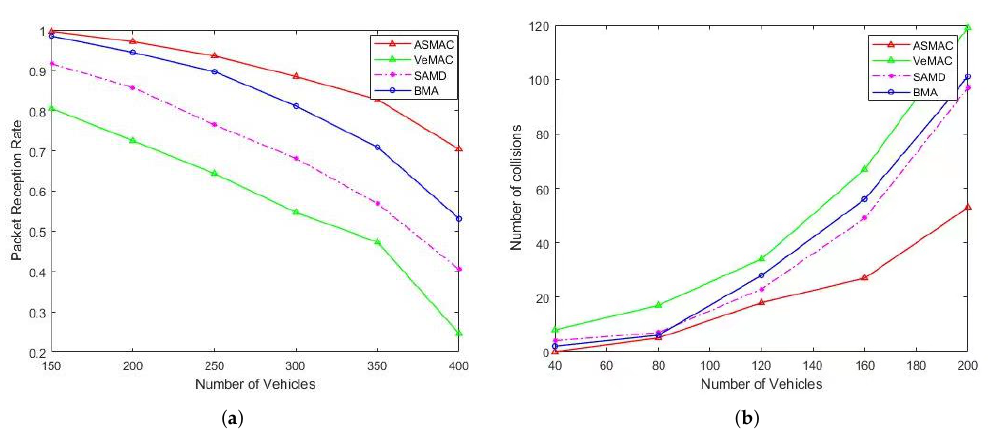
Figure 6. Packet reception rate and the number of collision on highway. ( a ) Packet reception rate. ( b ) Collisions.